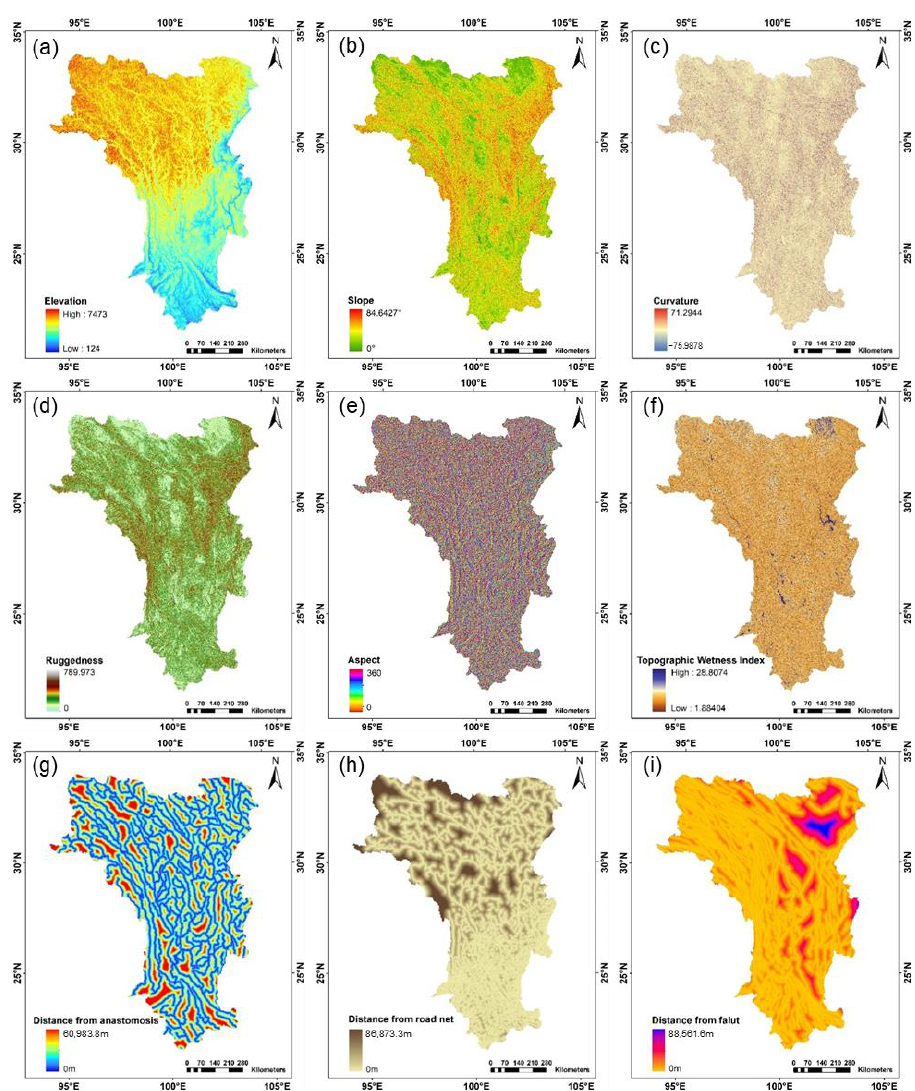
Figure 4. Static factors preselected: ( a ) elevation; ( b ) slope; ( c ) curvature; ( d ) terrain ruggedness index; ( e ) aspect; ( f ) topographic wetness index; ( g ) distance from anastomosis; ( h ) distance from road net; ( i ) distance from fault.